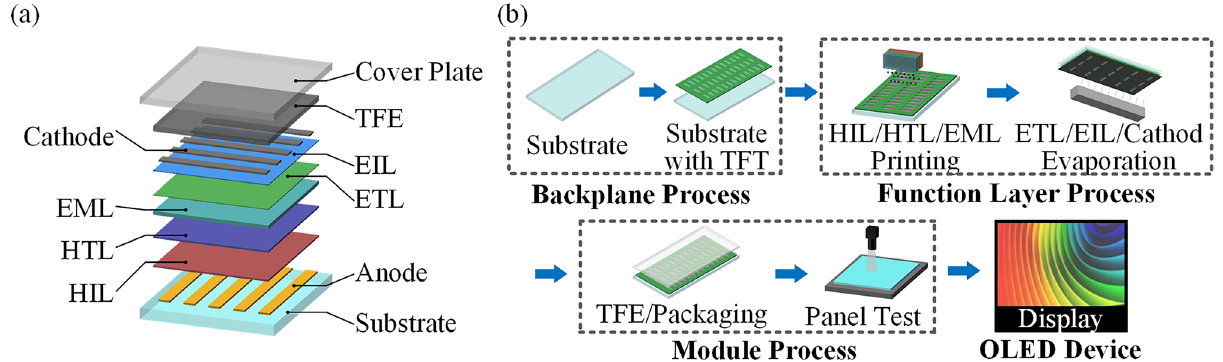
Figure 1. Simplified diagram of the OLED structure and production flow.